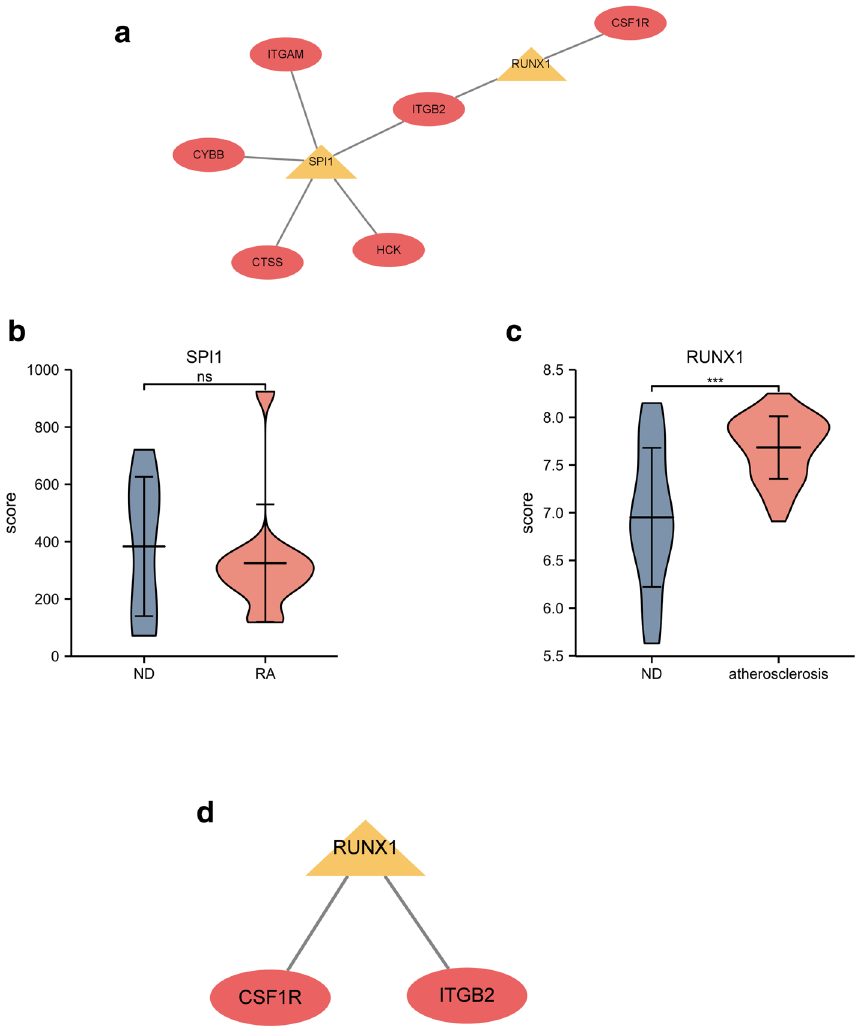
Figure 6. TFs regulatory network and its expression in GSE12021. ( a ) TFs regulatory network. ( b,c ) The expression level of TFs in GSE12021. *P < 0.05. ( d ) TF regulatory network that has been verified. TFs were marked in yellow, and the hub genes were marked in red.